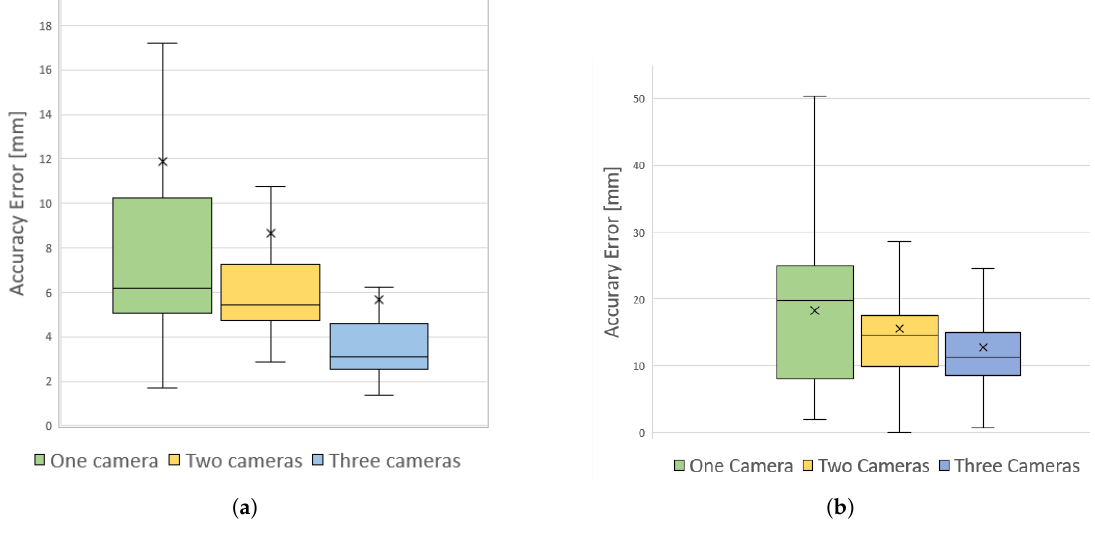
Figure 8. Comparison of detection when one, two or three cameras were used: ( a ) simulation; ( b ) experiment.